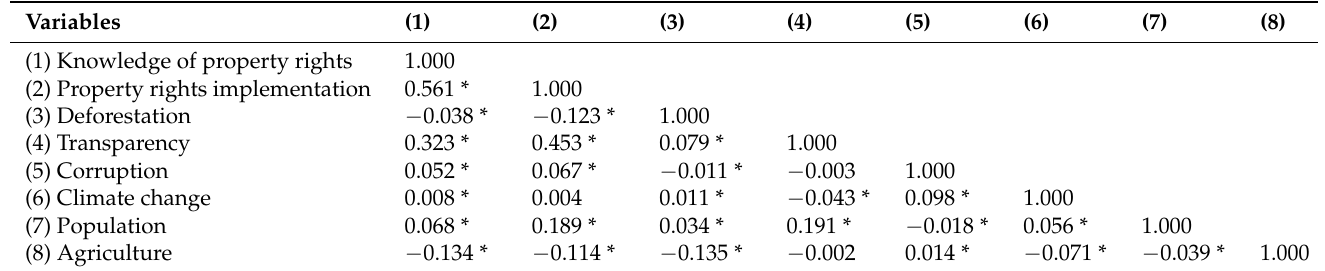
Table 3. Matrix of correlations: knowledge of property rights, property rights implementation, deforestation, transparency, corruption, climatic changes, population